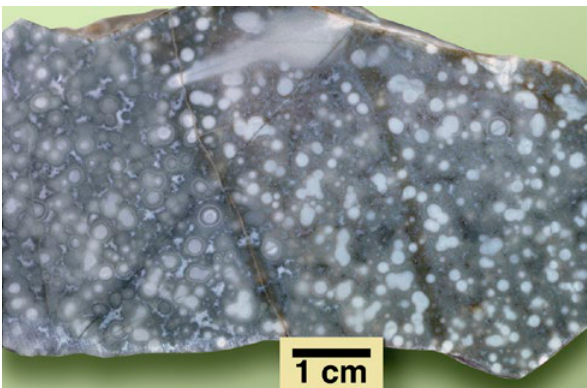
Figure 61. An irregular bulbous intrusion of impure cherty grey silica is part of the Mt. Morgan Mine lode system in Queensland. It has an “orbicular” or oolitic texture formed by concretion round small accretionary (denser synerectic) nuclei which were developed during intrusion and flow of the precursor polymeric silica. The texture positively indicates the silica gel precursor of this siliceous lode or